Question: Give a one-sentence summary of this figure.
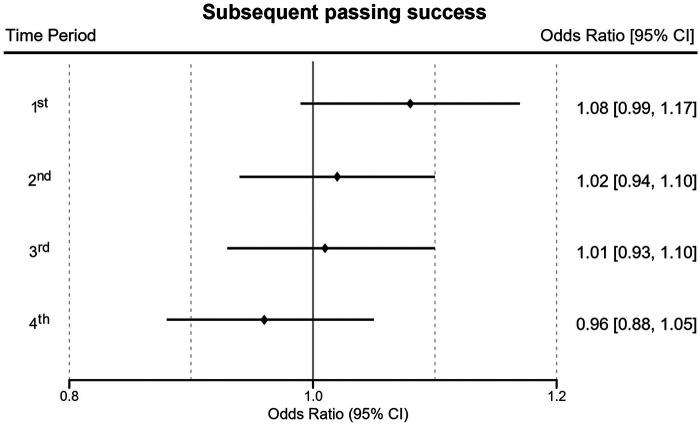
Answer: Odds ratios (95% CI) for each time period, describing the association between SF and subsequent passing success (1st = 0–2.5s, 2nd = >2.5–5 s, 3rd = >5–7.5s, 4th = >7.5 s–10 s).